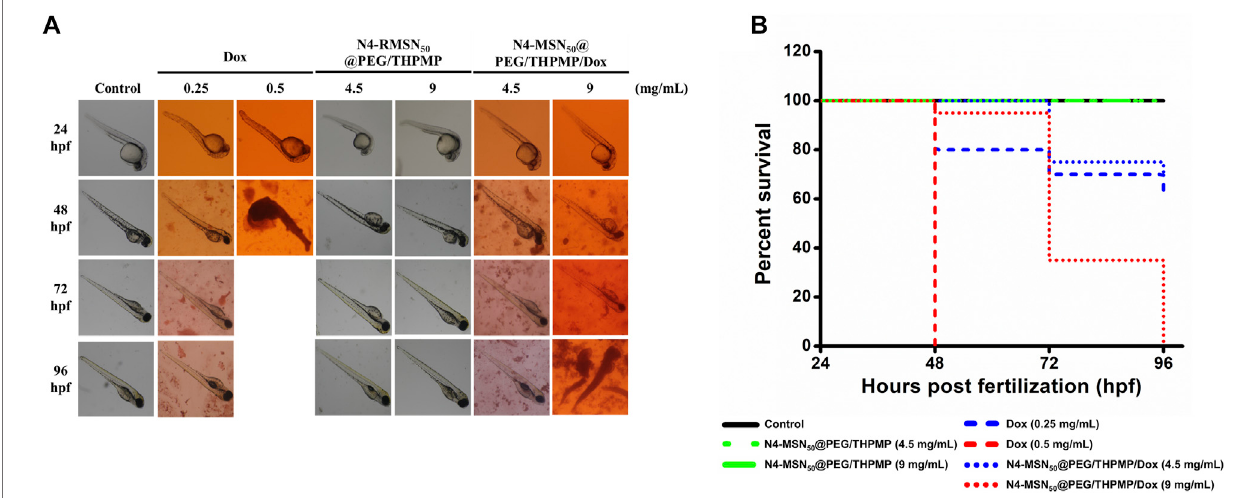
FIGURE 6 | N4-RMSN 50 @PEG/THPMP decreased doxorubicin (Dox) induced toxicity and increased the survival rate. (A) Representative optical images of zebra fi sh at 24 hpf stage after exposure to Dox (0.25 and 0.5 mg/ml), N4-MSN 50 @PEG/THPMP (4.5 and 9 mg/ml), and N4-MSN 50 @PEG/THPMP/Dox (4.5 and 9 mg/ ml) at an equivalent dose of Dox for 24, 48, 72, and 96 hpf. (B) Kaplan – Meier plots of overall survival. N = 20 (magni fi cation